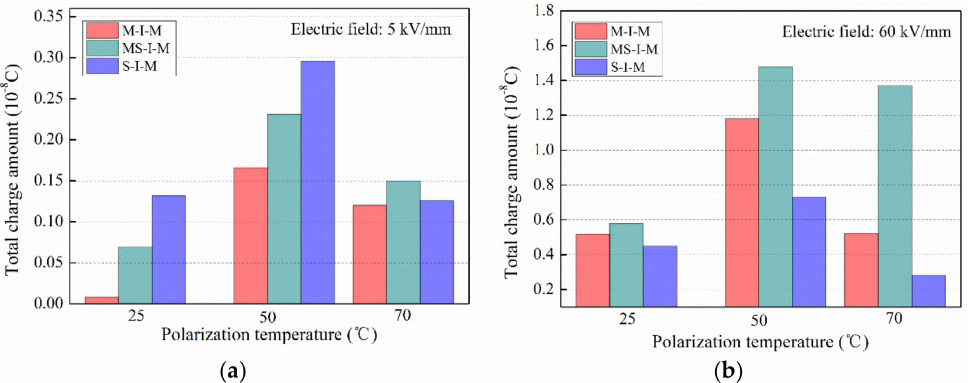
Figure 7. Total charge amount as a function of the polarization temperature in XLPE stressed of di ff erent electrode structures. ( a ) Low electric field of 5 kV / mm; ( b ) high electric field of 60 kV /